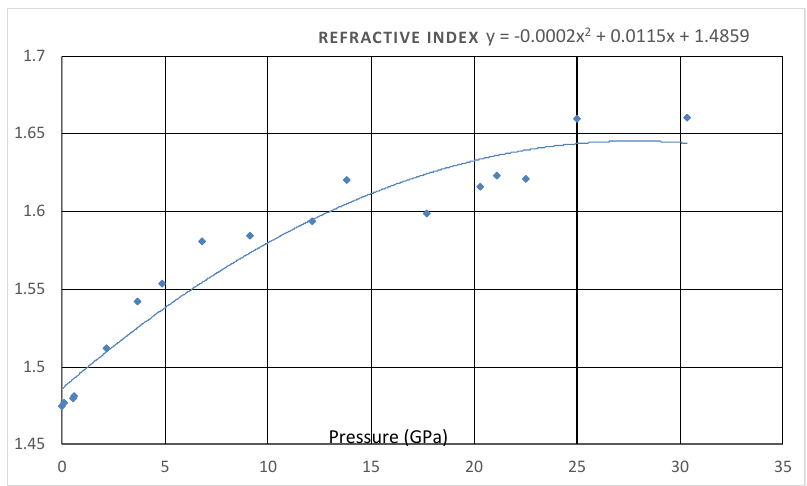
Figure A2. Data from Jae-Hyeon Ko of [42]; used with their permission. See text for discussion.